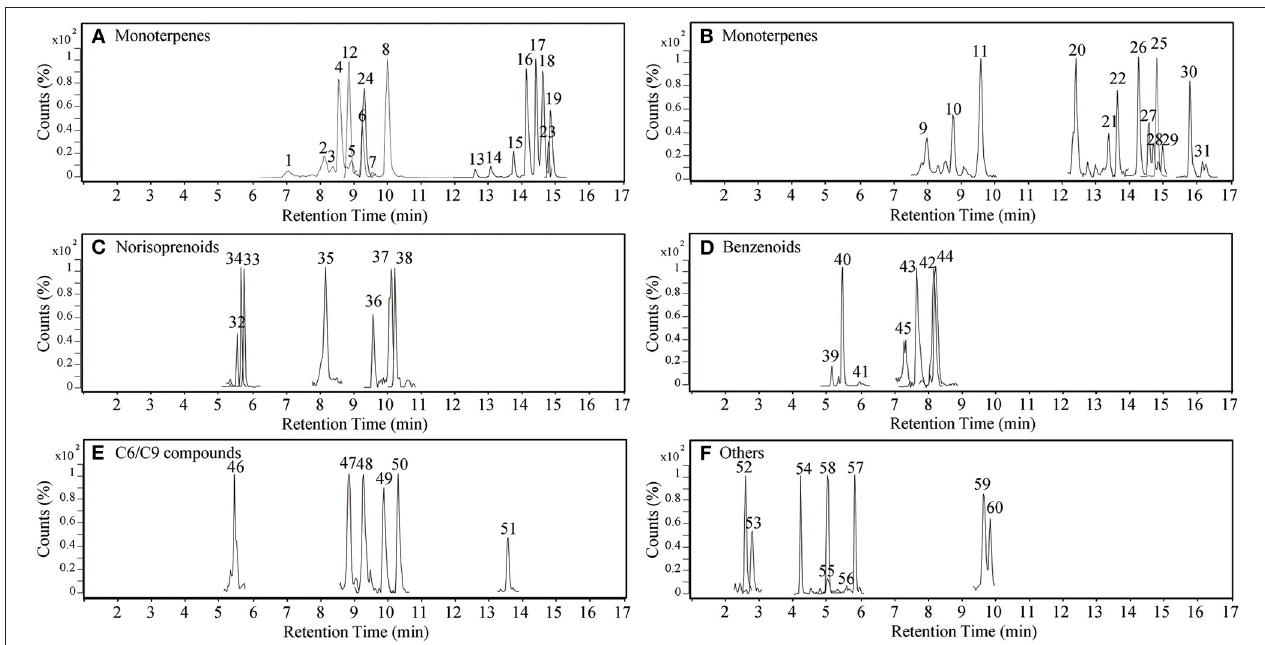
Table 1 , Supplementary Tables 2 , 3 , Figures 5 , 6